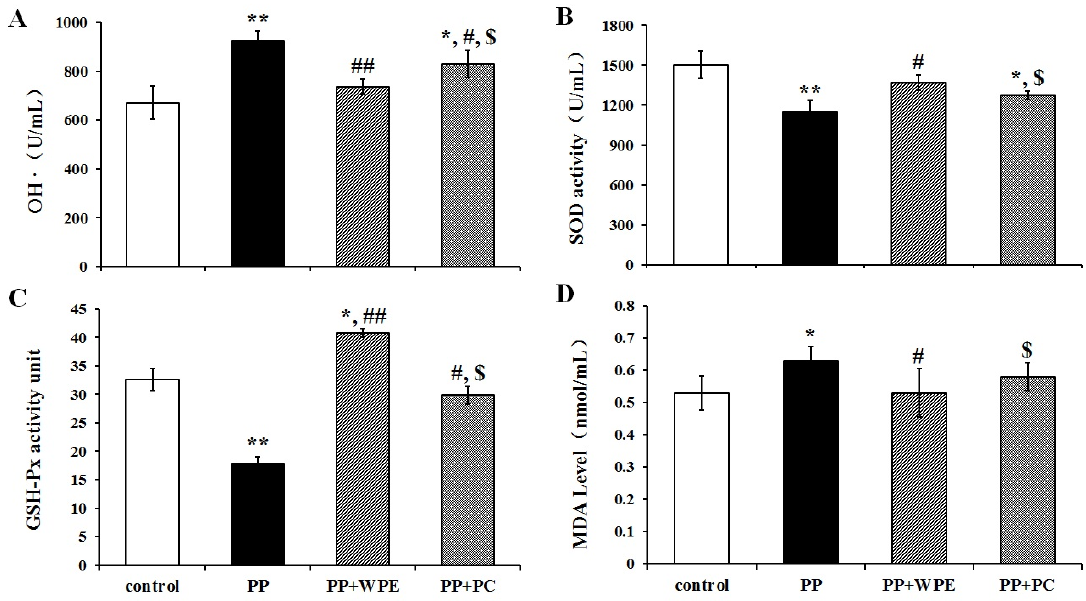
Figure 6. Effects of WPE on levels of ∙ OH, SOD, GSH ‐ Px, and MDA in splenocytes exposed to PP. Splenocytes were cultured in the presence of PP (10 − 4 M) or WPE (1.0 μ g/mL), PC (1.0 μ g/mL, together with PP for 48 h. Changes in ( A ) hydroxyl free radical ( ∙ OH) activity; ( B ) superoxide dismutase (SOD) activity; ( C ) glutathione peroxidase (GSH ‐ Px) activity; and ( D ) malonaldehyde (MDA) content in the cells were measured using specific assay kits. Results shown are means ± SD of three separate experiments. * p < 0.05 or ** p < 0.01 vs. untreated control; # p < 0.05 or ## p < 0.01 vs. PP treatment; $ p < 0.05 vs. WPE (1.0 μ g/mL) together with PP (10 − 4 M) treatment.